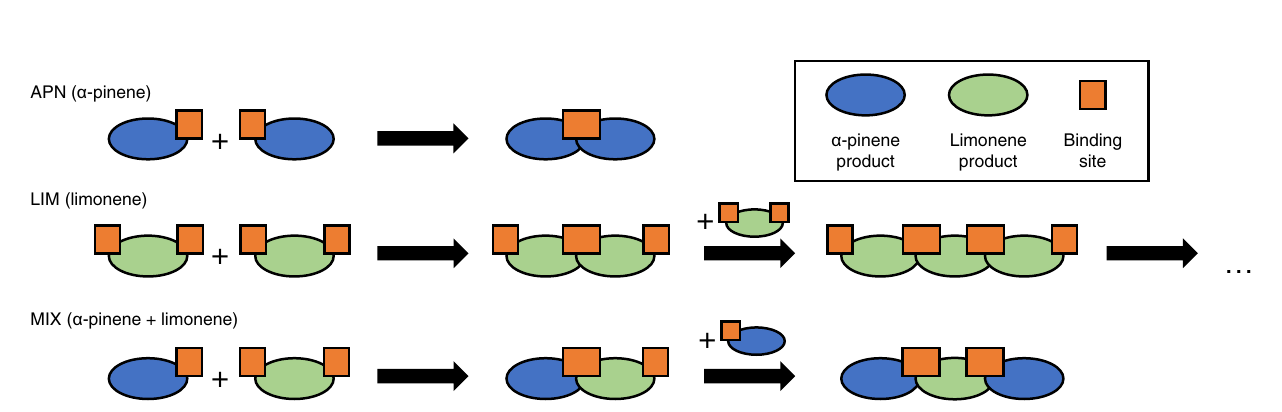
Fig. 6 | Schematic of oligomerization processes in single- and multi-precursor systems. Limonene oxidation intermediates/products (green) are likely to have twice as many oligomerization sites (orange; i.e., peroxy radicals (RO 2 · ) and func- tional groups) as α -pinene oxidation intermediates/products (blue) due to the